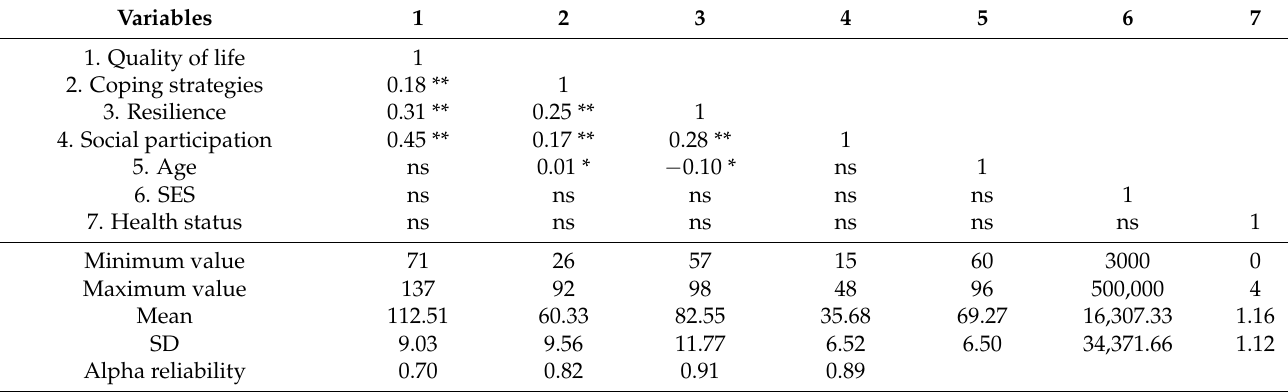
Table 2. Descriptive statistics, inter-correlations, and reliabilities for the study